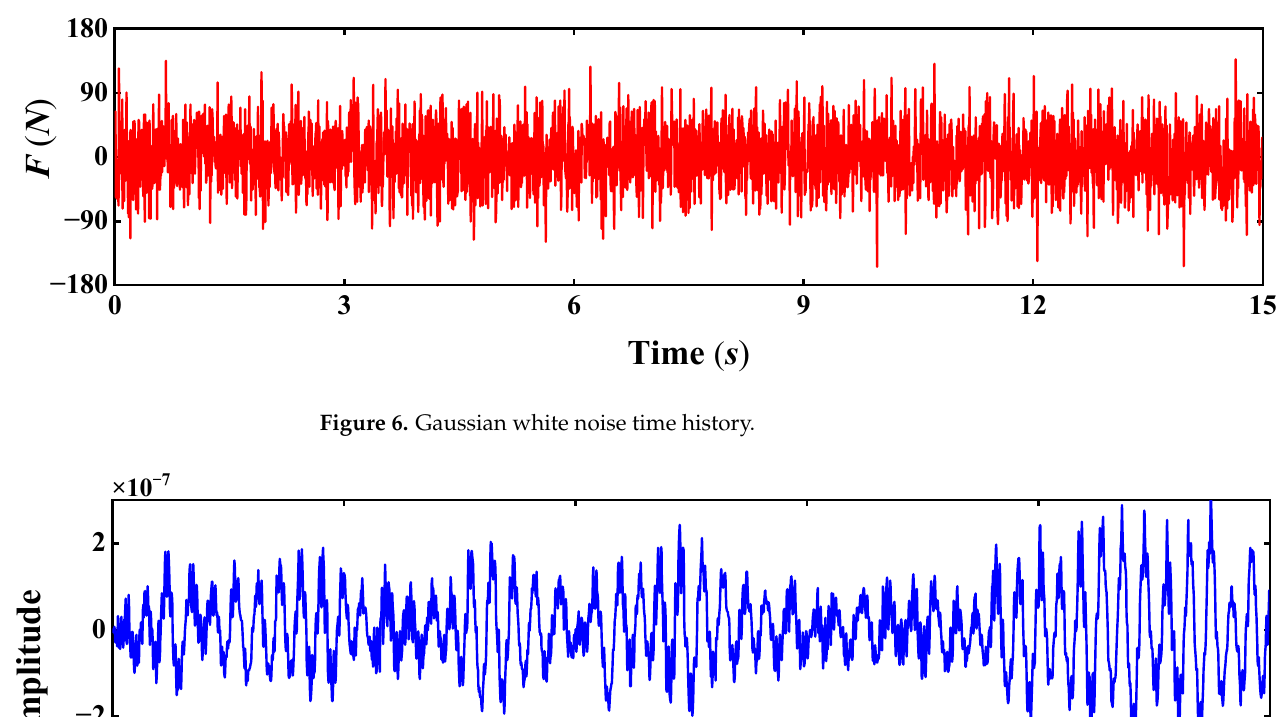
Figure 5. Model diagram of cracked cantilever beam: ( a ) schematic diagram; ( b ) crack state; ( c ) cross section.